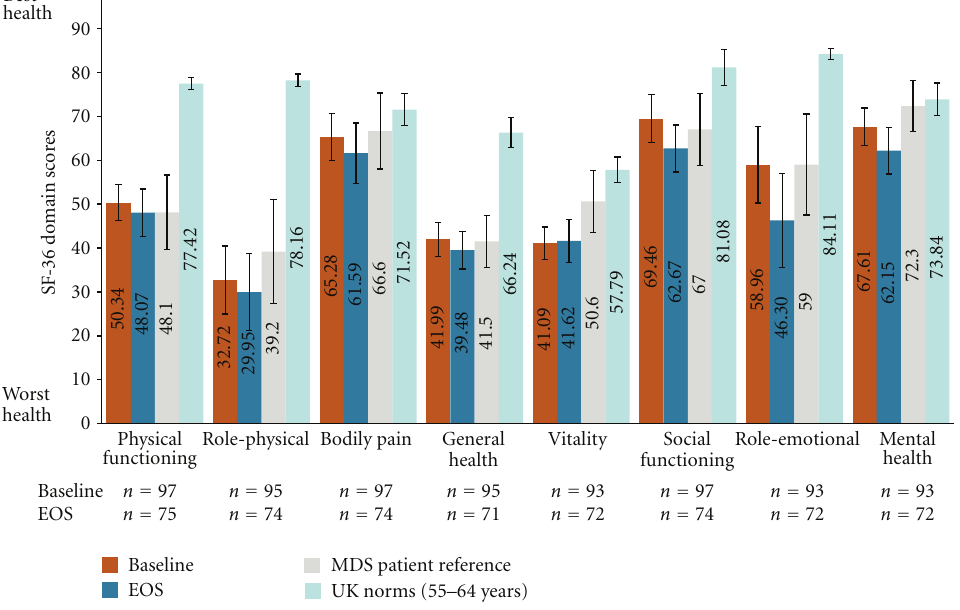
Figure 2: Mean SF-36 domain scores for MDS population versus MDS and general population references at baseline and EOS. Data illustrated in the above figure are representative of the mean and 95% confidence interval estimates of the mean as calculated using the ÷√ n . Transfusion-dependent MDS patient reference data reported by Jansen et al. [17]; UK norms from formula: 1.96 ∗ standard deviation Jenkinson et al. [42] and direct email communications from Dr. Jenkinson on Oct 24, 2011 with age-specific